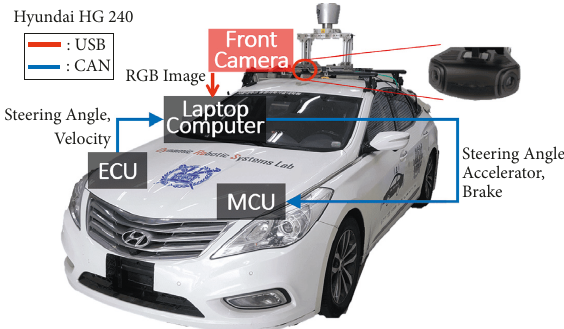
Figure 9: Autonomous vehicle hardware system